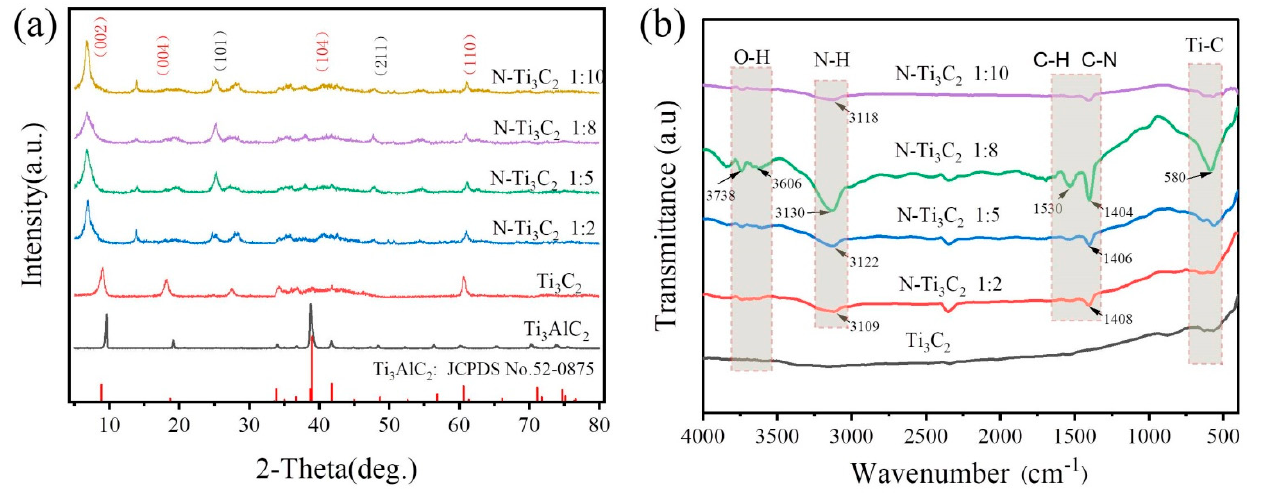
Figure 4. ( a ) XRD patterns of Ti 3 C 2 MXene and N − Ti 3 C 2 MXene nanomaterials; ( b ) FTIR spectra of Ti 3 C 2 and N − Ti 3 C 2 MXene.